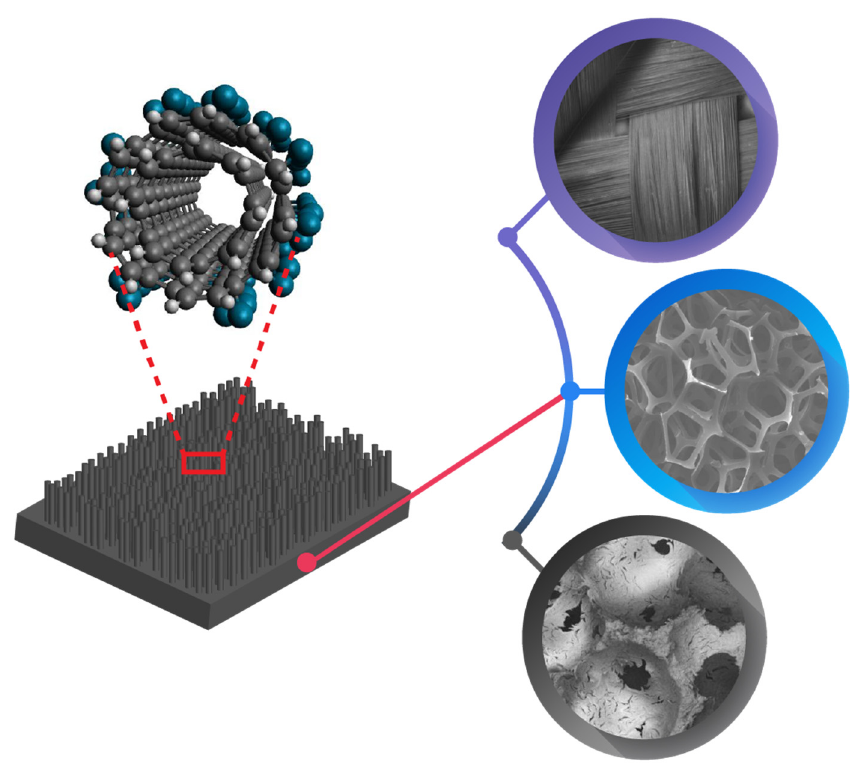
Figure 5. Schematic of hierarchical structure, where carpet-like arrays of CNT are strongly attached to a porous carbon substrate. Carbon substrate can be flexible carbon fiber cloth ( right-top ), reticulated vitreous carbon foam ( right-middle ) or micro cellular carbon foam ( right-bottom ).